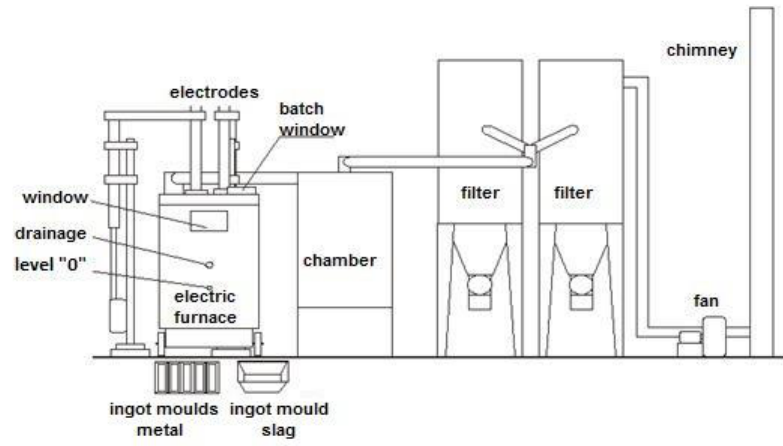
Figure 2. Diagram of the experimental electric furnace installation.